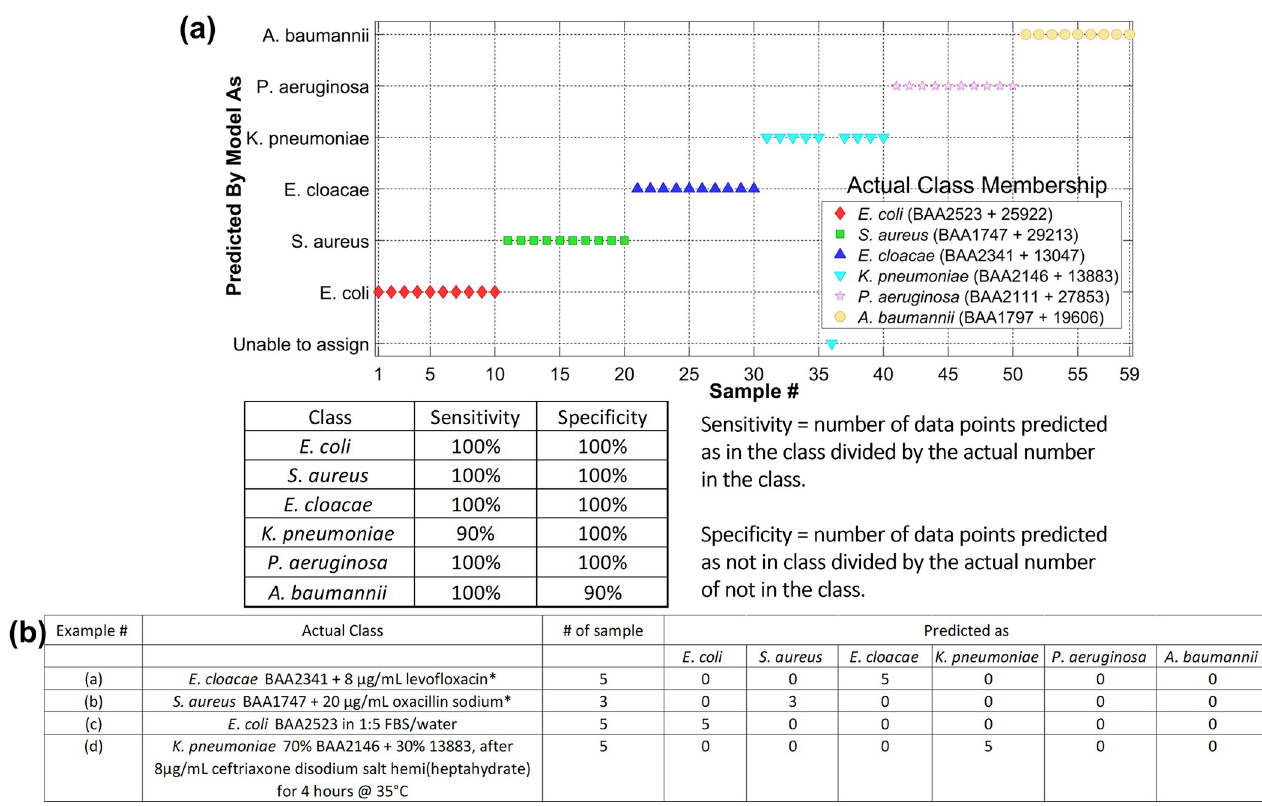
Fig 6. Automatic spectral analysis by machine learning models (a) > 95% species specificity and sensitivity achieved in distinguishing six bacterial species based on ATR spectral features. (b) numerical summary of classification results by the machine learning model for four different unknown samples.